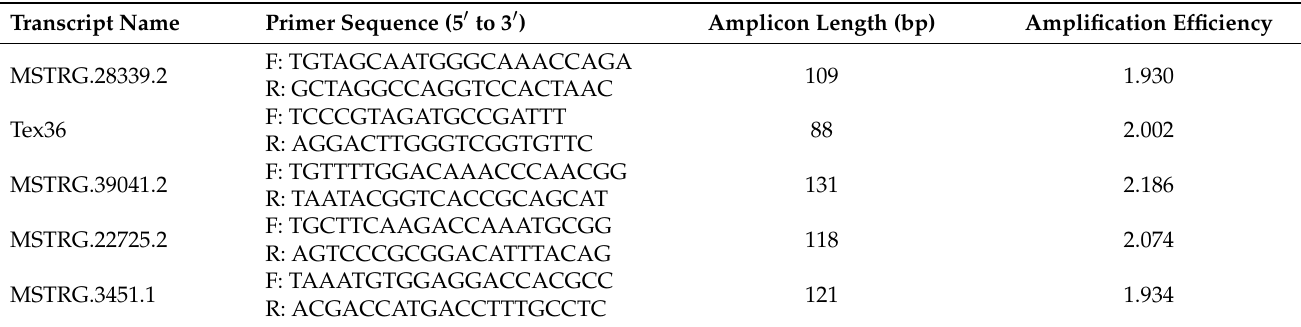
Table 1. Primer nucleotide sequences used in this